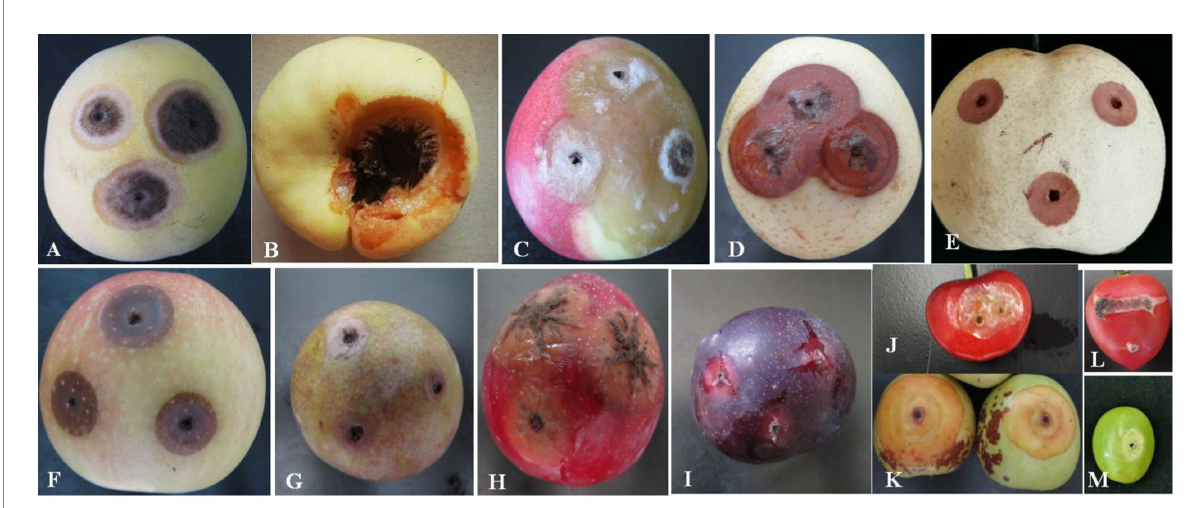
FIGURE 6 Pathogenicity of A. niger to different local fruits. (A) Yellow peach; (B) flat peach; (C) nectarine; (D) snow pear; (E) sand pear; (F) apple; (G) carmine plum; (H) red plum; (I) black plum; (J) cherry; (K) jujube; (L) tomato; and (M)